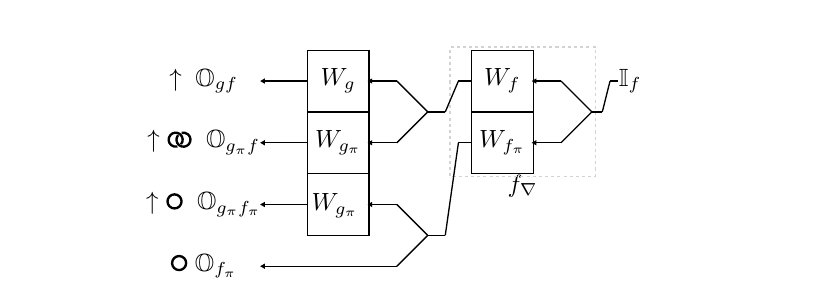
Figure 8: The vulnerability profile of a composition of functions when considering extended probes.